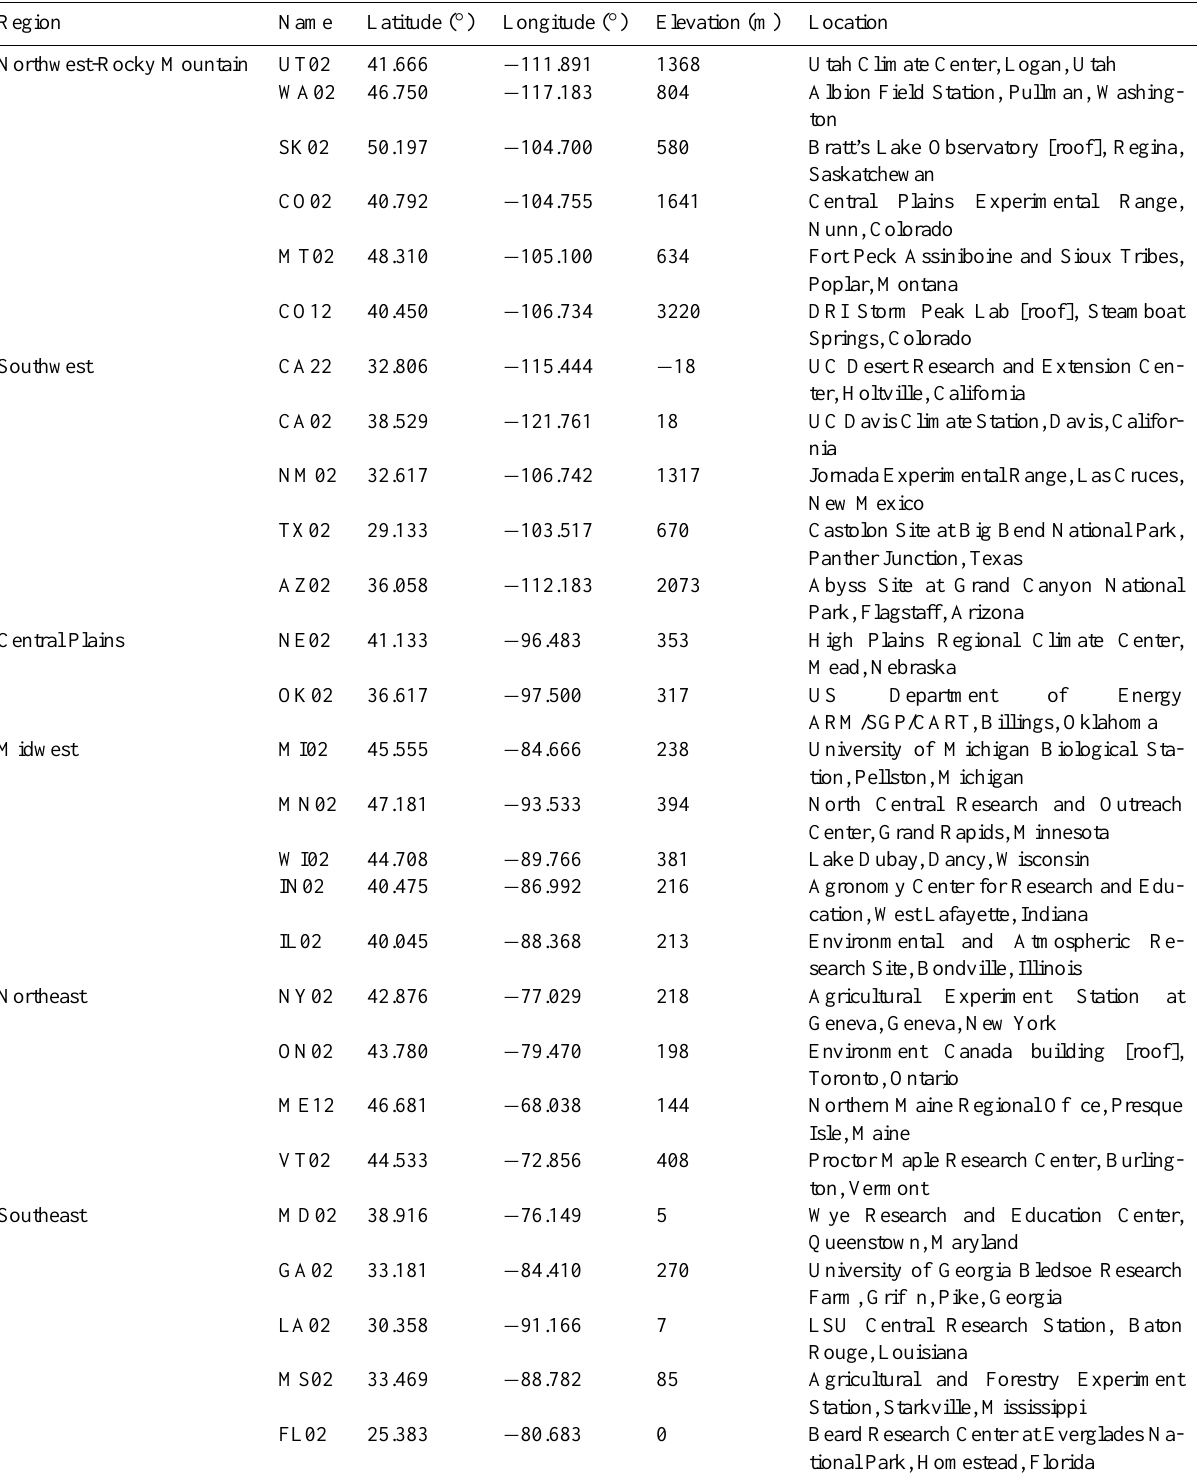
Table 1. The geographical information and brief descriptions of 27 UVMRP observation sites. The geographical distribution map for the monitoring sites can be found at the UVMRP website (http://uvb.nrel.colostate.edu/UVB/uvb network.jsf).